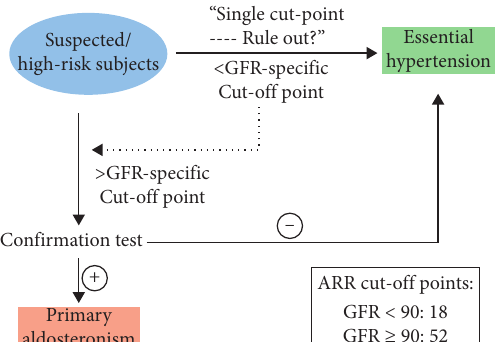
Figure 3: Recommended approach for the use of ARR in the screening for PA. The protocol was interpreted as follows. Firstly, we enrolled subjects in accordance with the inclusion criteria and exclusion criteria. Then confirmation tests were conducted in every hypertension case with PAC higher than 10 ng/dl to fully ensure no PA cases were missed, regardless of the ARR value. Finally, PA was carefully diagnosed in cases with positive confirmation test results and clinical